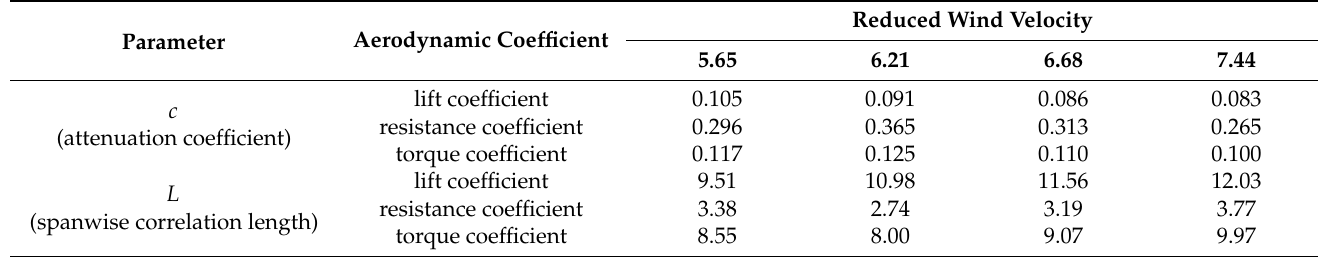
Table 4. Fitting value of aerodynamic spanwise correlation coefficient parameters and spanwise correlation length of the main beam in a static